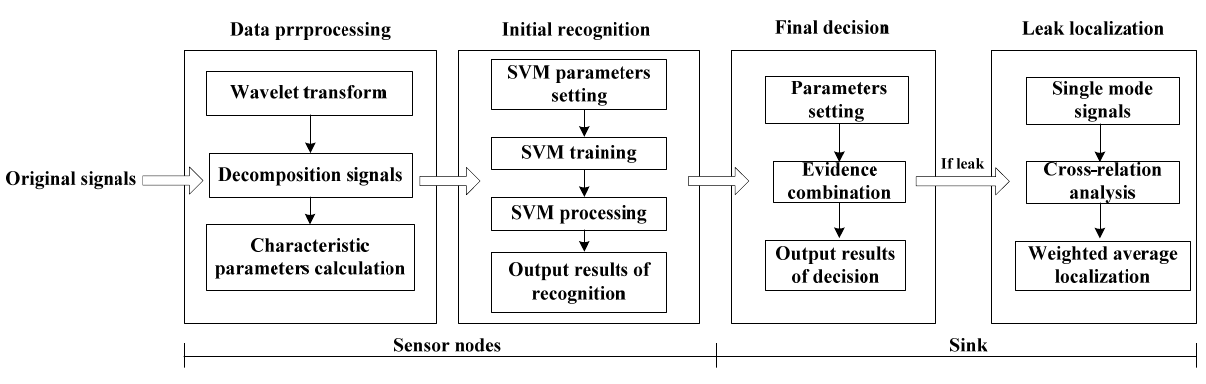
Figure 2. Hierarchical model for leak detection and